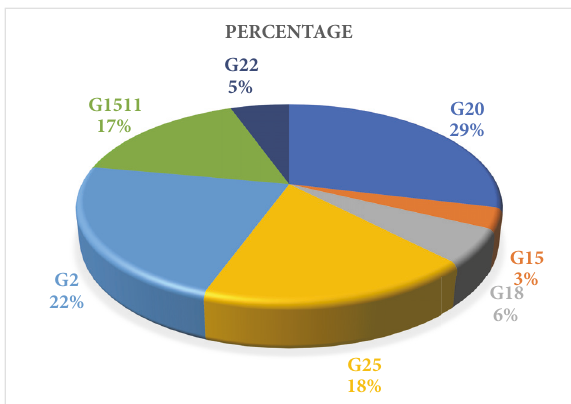
Table 3: The results of the modification. Black spots 𝑗 Original Pile No.